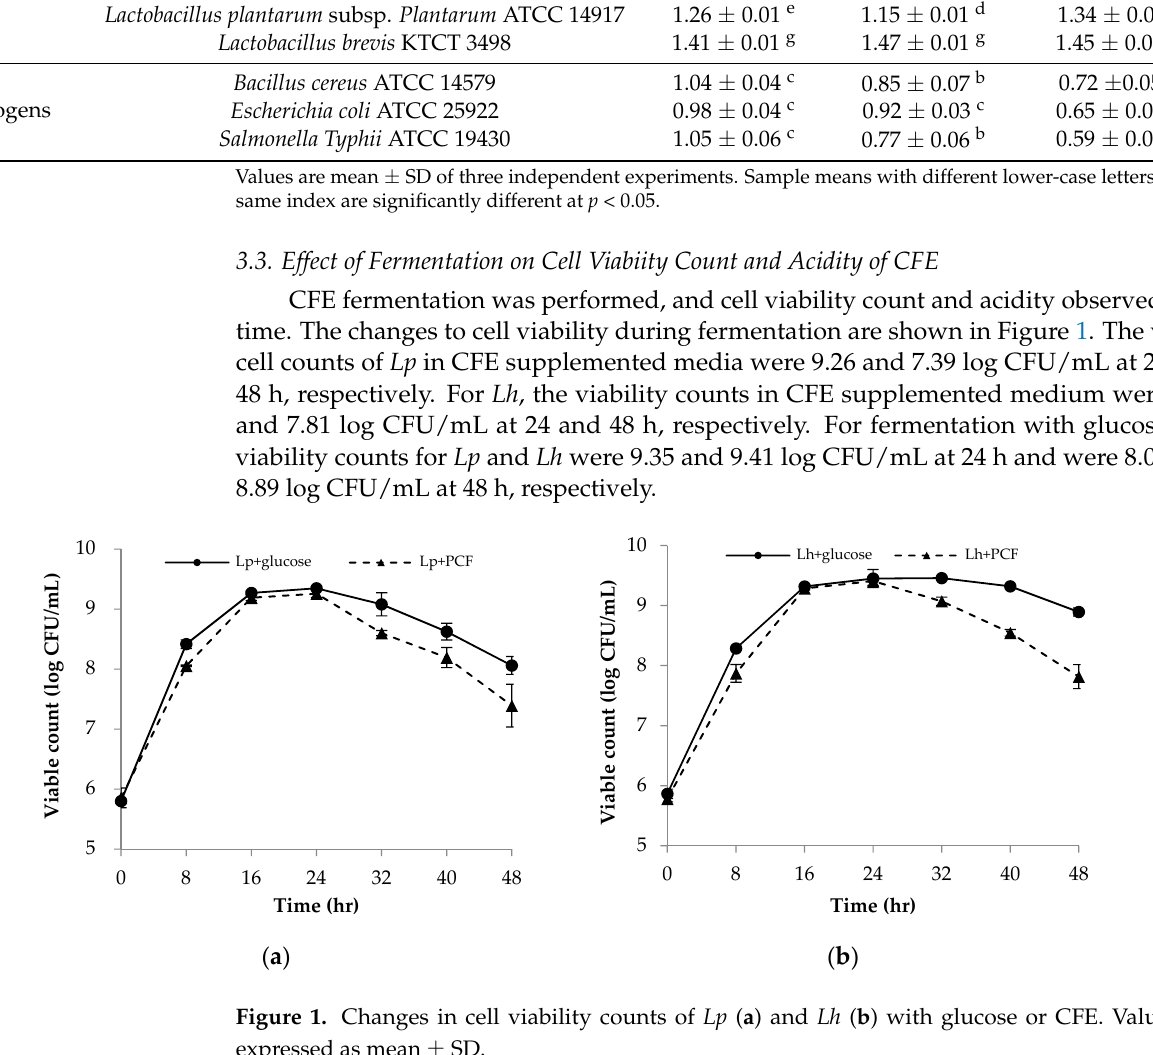
( b ) Figure 2. Changes in acidity of Lp ( a ) and Lh ( b ) with glucose or CFE. Values are expressed as mean ± SD. Table 3 shows SCFAs content after in vitro fermentation of CFE by mouse feces. When CFE was employed as the carbon source, acetic acid concentration was signifi- cantly higher than that of the mouse fecal-fermented sample. Butyric acid and propionic acid were not detected. Table 3. SCFAs contents after in vitro fermentation of CFE by mouse feces. Sample